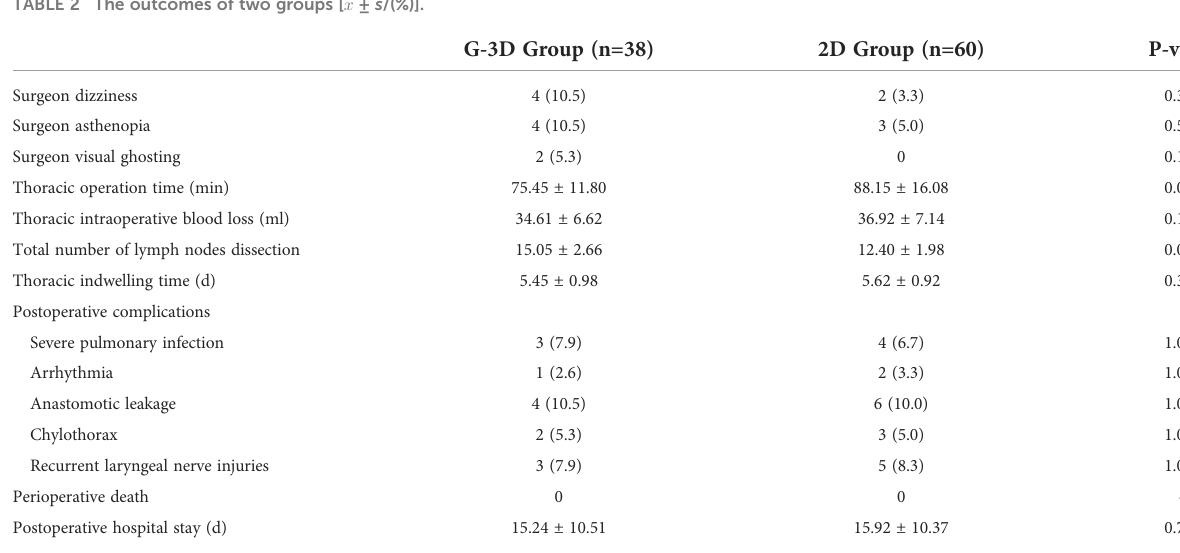
TABLE 2 The outcomes of two groups [ (cid:1) x ± s